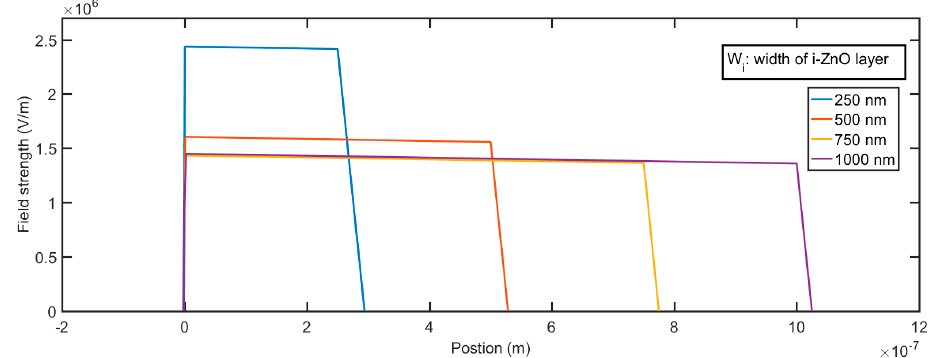
Figure 8. Field profile of the p-Si/i-ZnO/n-AZO structure for different widths of the i-ZnO layer.